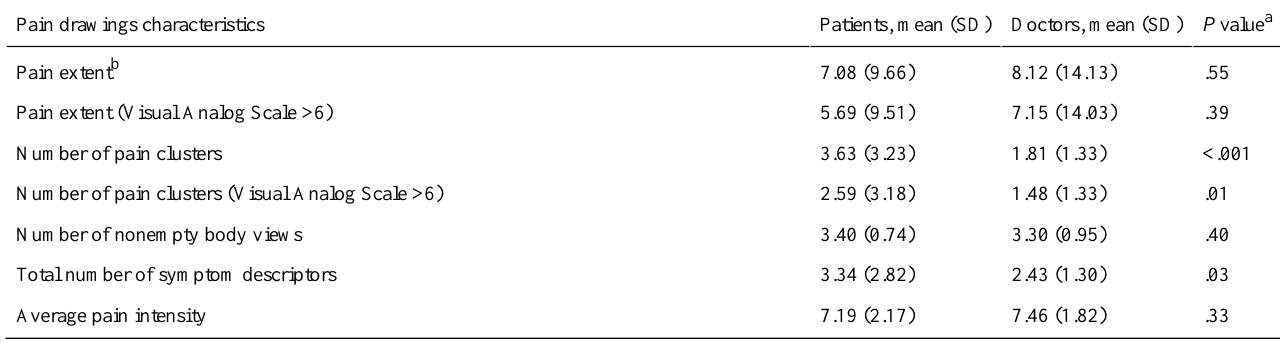
Table 4. Comparison of doctors’and patients’pain drawing